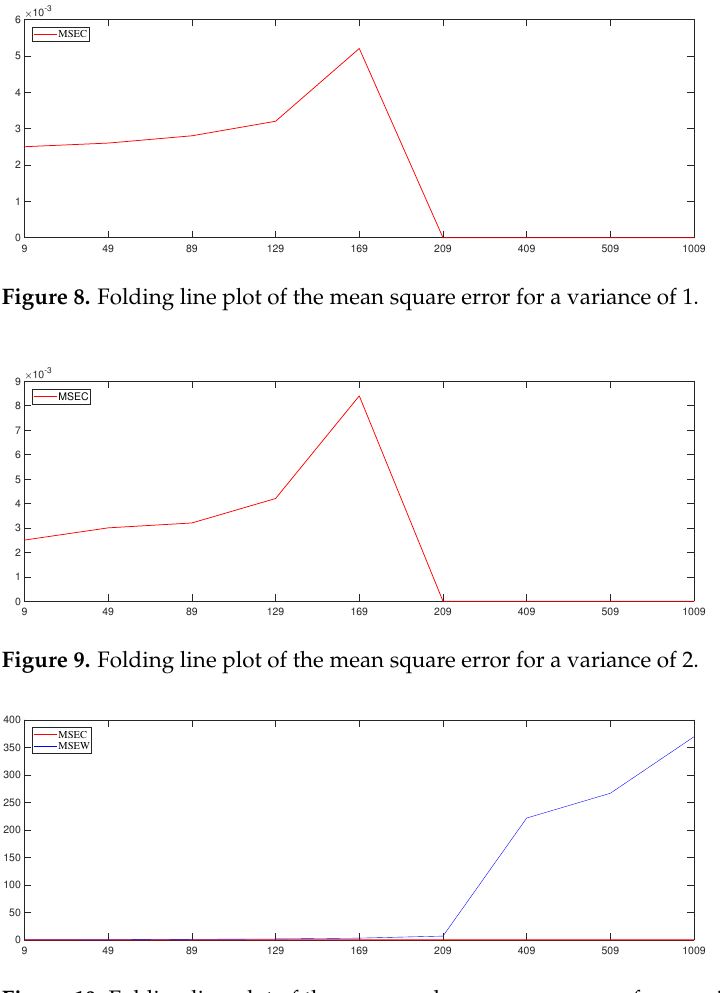
Figure 10. Folding line plot of the compared mean square error for a variance of 0.5.